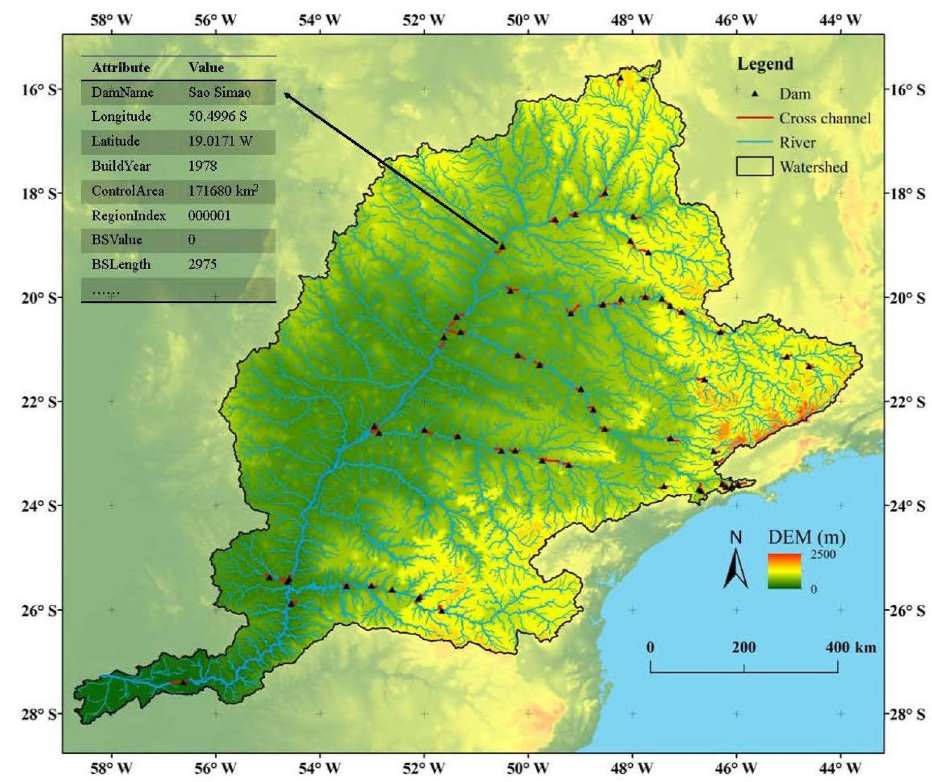
Fig. 2 Topological relationships between large dams and river reaches in the La Plata River